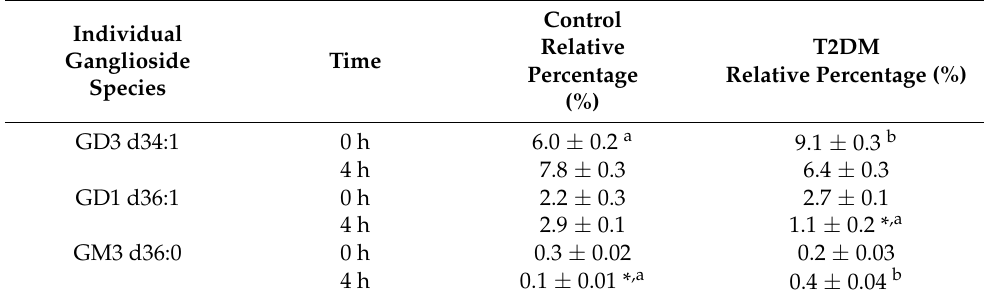
Table 4. Relative percent of individual ganglioside species in chylomicrons at 0 and 4 h postprandial in control and T2DM